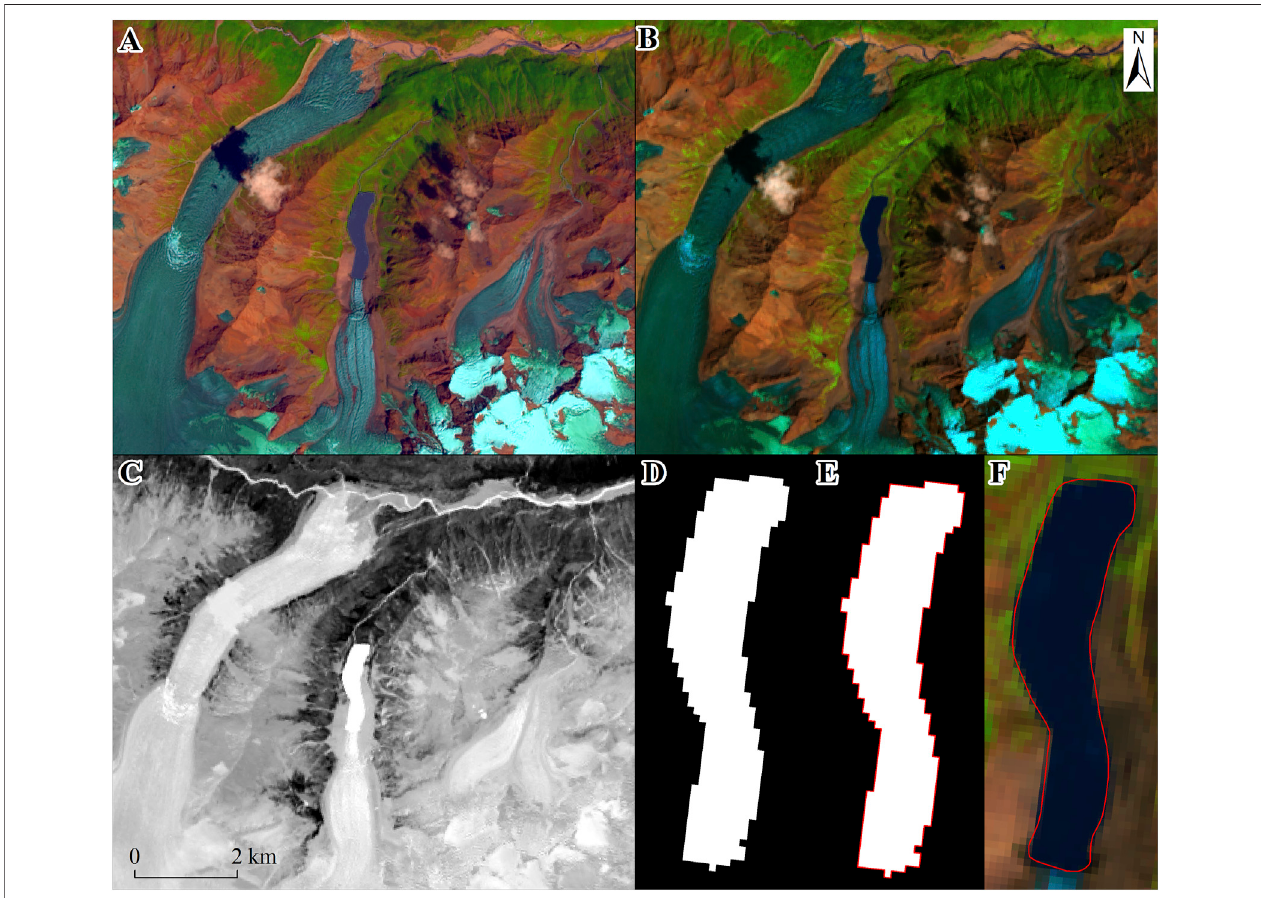
FIGURE 3 | Process of automated lake delineation. (A) is Landsat OLI composed image (acquired on 18 August 2016, band 6-5-2 as RGB); (B) is image after performingradiometriccalibration and fl ashatmospheric correction; (C) isNDWIimage; (D) istheextentoftheJGLwhen thethreshold is0.16; (E) istheJGLoutlineina vector format overlapped on the binary image; (F) is the JGL outline after manual revision.